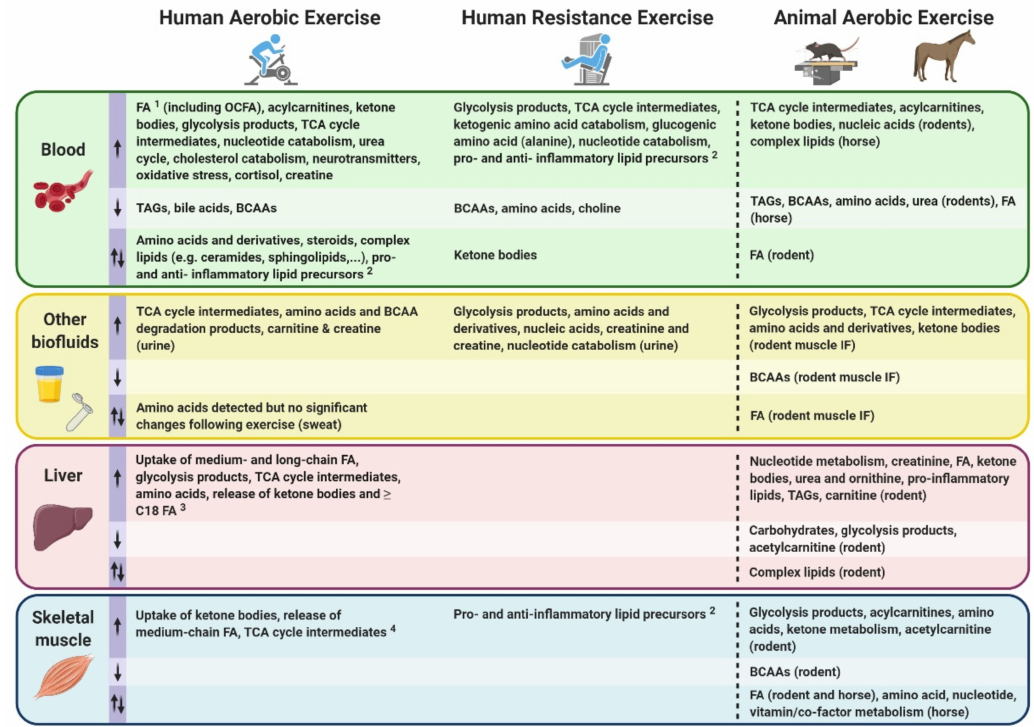
Figure 3. Summary of the current exercise molecular landscape of metabolomic and lipidomic findings discussed from the past decade. Dynamic changes in metabolites and lipids (i.e., increased, decreased, or shown to be changed in both directions) occurring in response to acute aerobic and resistance exercise are summarized across various biological systems (i.e., blood and other biofluids including urine and sweat; and tissues such as liver and skeletal muscle) in humans and other mammalian species. This figure focuses on early responses (0–30 min) following an acute exercise bout except for data collected from horses within the first three hours post-exercise. Metabolomic responses can therefore show different directionality based on timing and exercise variables, as mentioned previously. BCAAs: branched-chain amino acids, FA: fatty acids, IF: interstitial fluid, OCFA: odd-chain fatty acids, TAGs: triacylglycerols, TCA: tricarboxylic acid. 1 Changes in FA levels post-exercise may depend on carbon chain length and although circulating levels of most FA have been reported to increase following an acute exercise bout, post-exercise decreases in some FA chain lengths (e.g., C20 to C24) have also been observed. 2 Directionality of specific lipid mediators in human blood and skeletal muscle are not detailed in this figure, and responses to exercise may vary depending on the specific lipid mediators within their broader classes. Refer to Table S2 for information regarding the directionality of specific pro- and anti-inflammatory lipid precursors following exercise. The metabolite directionalities of human liver 3 and human skeletal muscle 4 depicted in this figure are derived from data analyzing hepato-splanchnic bed and arterio-venous differences, respectively, rather than from tissue biopsies. Up arrow: increase; down arrow: decrease; bidirectional arrow: both increase and